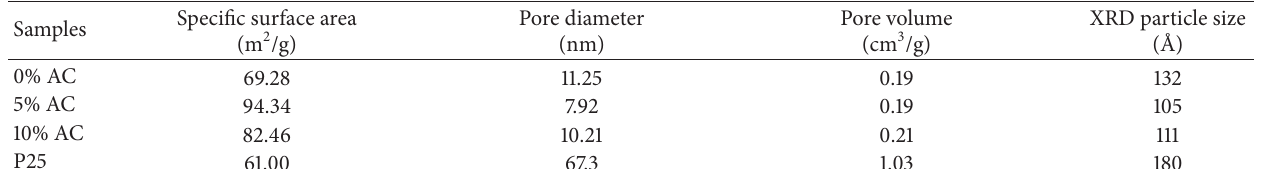
nanoparticles. 2